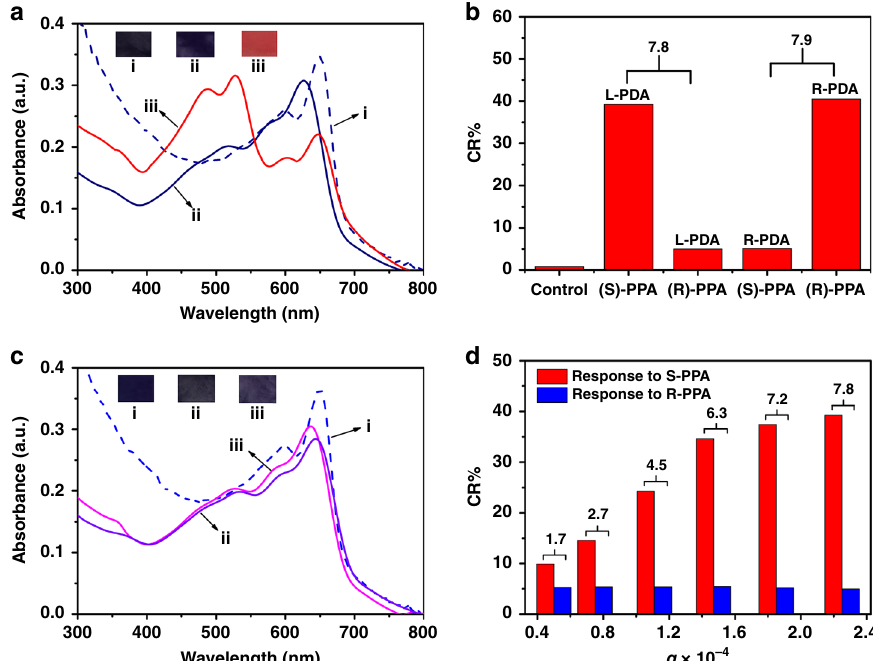
Fig. 5 UV – vis spectra and CR values. UV – vis absorption spectra of chiral PDA fi lms prepared with left-handed a SCL and c CPL: (i) before treatment,